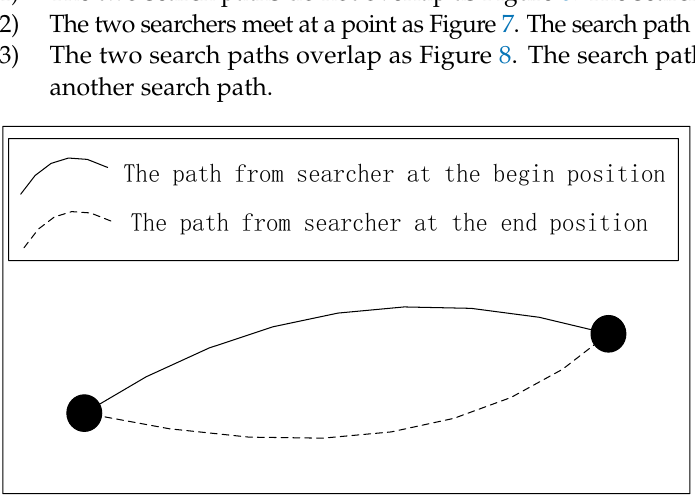
The path from searcher at the begin position The path from searcher at the end position